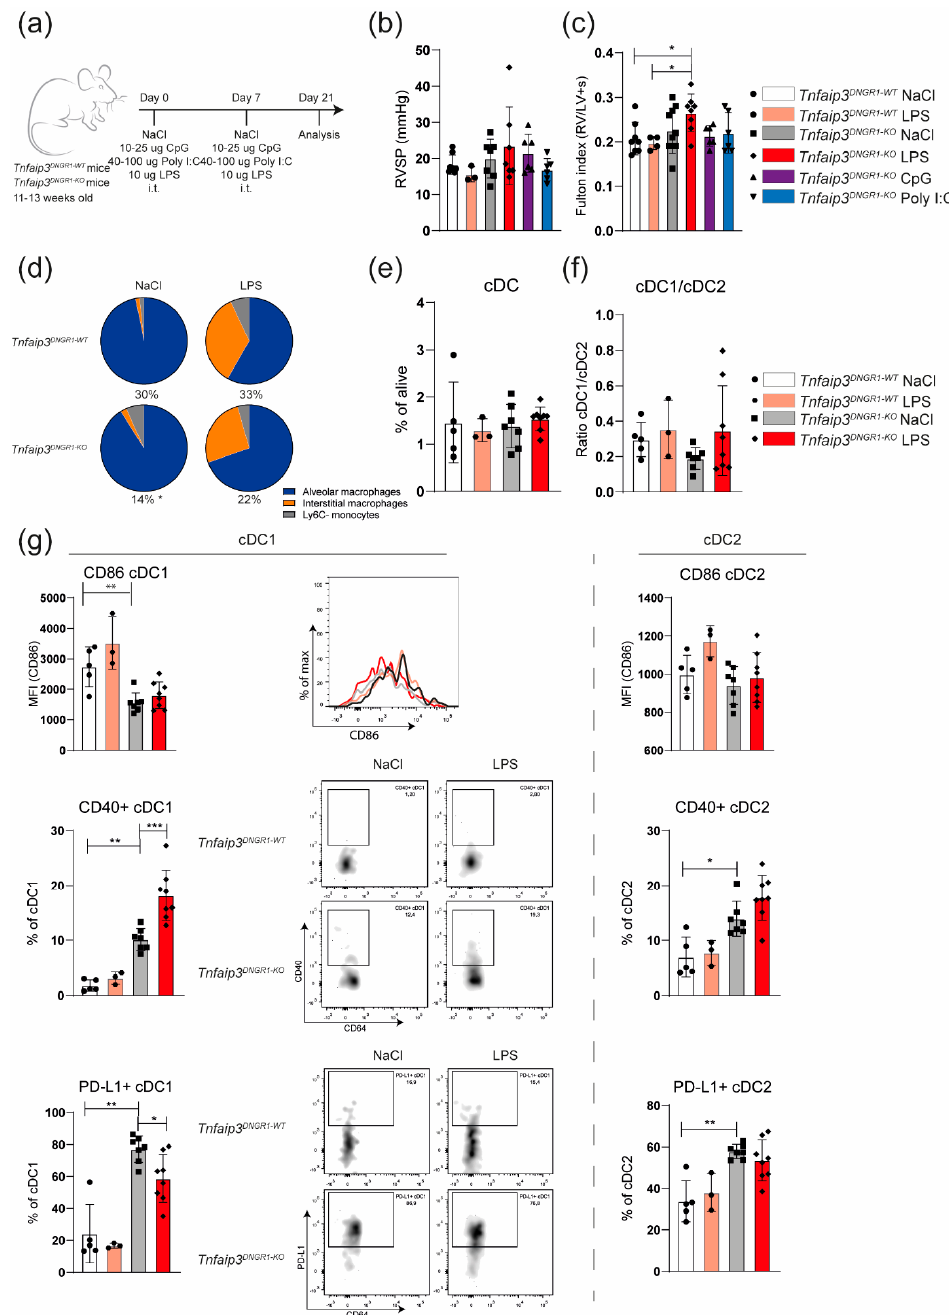
Figure 2. TLR4 activation leads to RV hypertrophy and cDC1 phenotype changes in Tnfaip3 DNGR1 ‐ KO mice. ( a ) Scheme of intratracheal (i.t.) administration of CpG, lipopolysaccharide (LPS) and polyinosinic ‐ polycytidylic acid (Poly I:C) in WT and Tnfaip3 DNGR1 ‐ KO mice on day 0 and 7, and analysis on day 21; ( b ) right ventricular systolic pressure (RVSP) in toll ‐ like receptor (TLR) ‐ exposed WT and Tnfaip3 DNGR1 ‐ KO mice, determined by right heart catheterization; ( c ) hypertrophy of RV measured by Fulton index (right ventricle/ left ventricle + septum); ( d ) assessment of the indicated cell types in LPS-exposed WT and Tnfaip3 DNGR1-KO mice. Proportion of the CD64 + GR1 − macrophage/monocyte population from total alive cells is indicated below the pie charts; ( e , f ) quantification of total DCs ( e ) and the CD103+ cDC1/CD11b+ cDC2 subset ratio ( f ) in the lungs of the indicated mice, as determined by flow cytometry; ( g ) quantification of surface CD86, CD40 and PD-L1 expression on CD103+ cDC1s (left) and CD11b+ cDC2s (right) in the indicated mouse groups. Flow cytometry analyses are shown as histogram overlays of CD86 expression (top), as dot plots with CD64/CD40 profiles (middle) and dot plots with CD64/PD-L1 profiles (bottom) of gated cDC1s. Results are presented as mean values + standard deviation of 3–10 mice ( b , c ) or 3–6 ( e – g ) mice per group. MFI = median fluorescence intensity. * p < 0.05, ** p < 0.01, *** p <